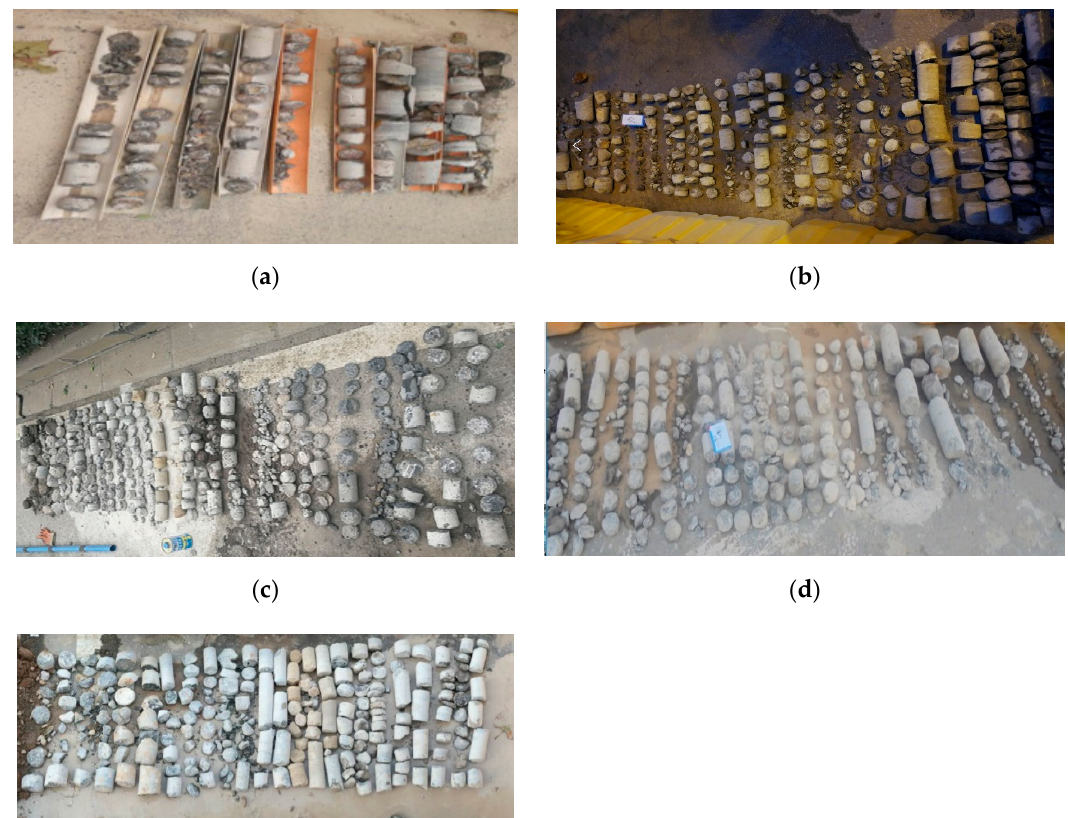
Figure 13. Drilling core drawing. ( a ) Coring of hole h1; ( b ) Coring of hole h2; ( c ) Coring of hole h3; ( d ) Coring of hole h4; ( e ) Coring of hole h5.